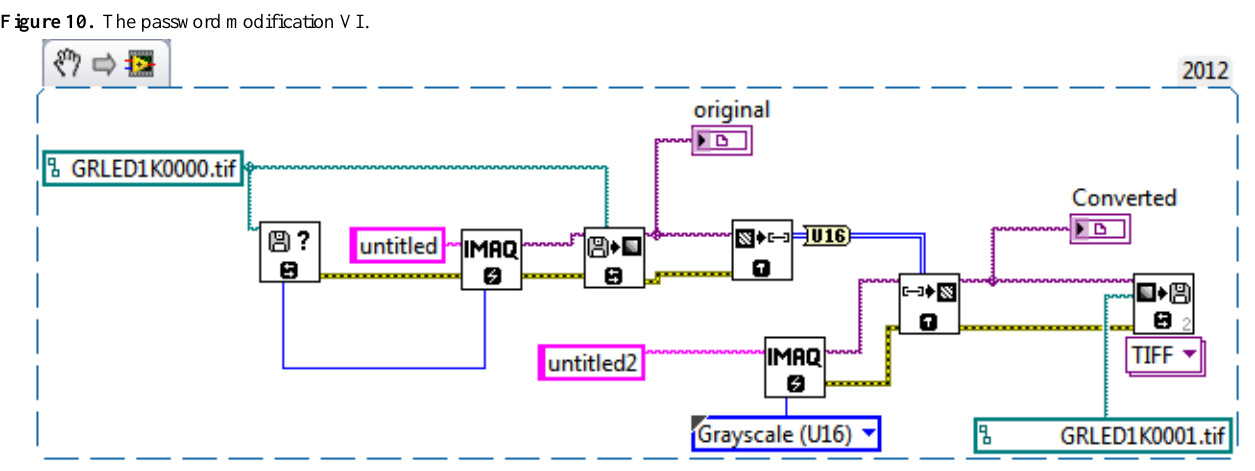
Figure 10. The password modification VI.